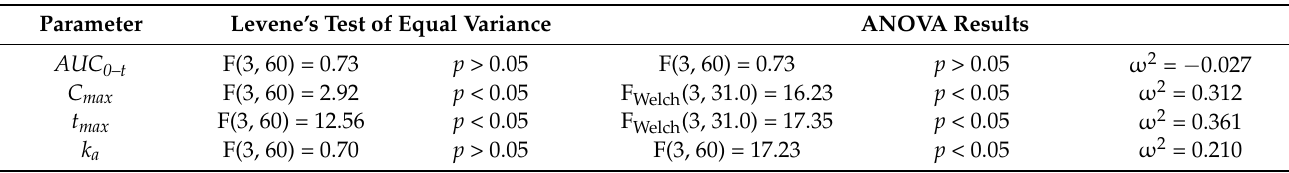
Table A6. Detailed ANOVA results (comparison to existing data on the marketed formulation with a non-cross-over